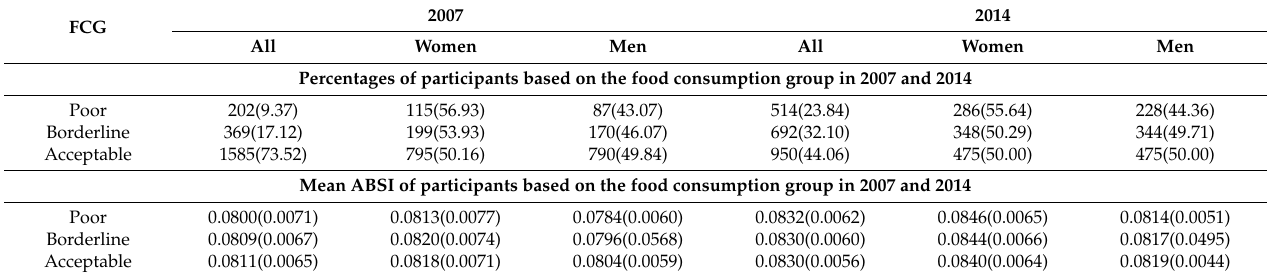
Table 2. Percentage and mean of a body shape index (ABSI) of participants based on the food consumption group in 2007 and